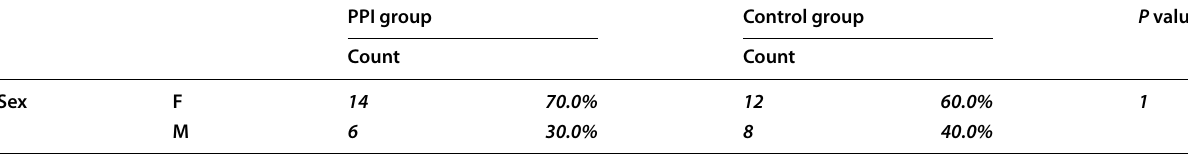
Table 2 Distribution of sex in both groups before surgery